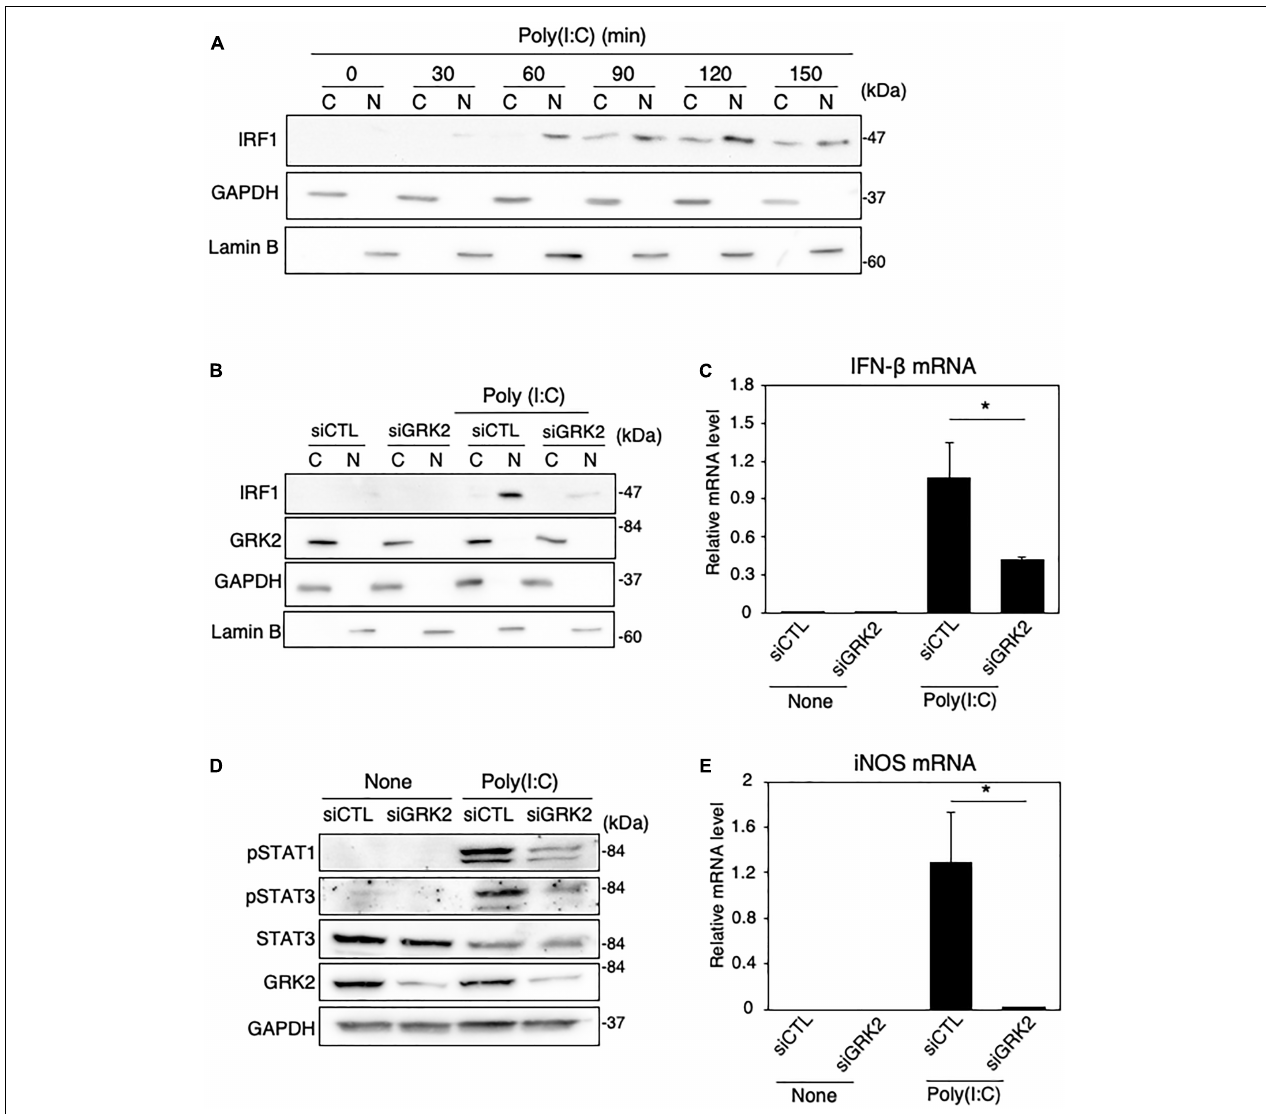
FIGURE 8 | Effect of GRK2 siRNA transfection on TLR3-mediated signaling for iNOS expression in MG6 cells. (A) Cytoplasmic (C) and nuclear (N) fractions were isolated, and then the time course of changes in IRF1 levels in each fraction after 50 µ g/ml poly(I:C) application was tracked by Western blot analysis. (B) Effect of transfection of GRK2 siRNAs (siGRK2) on nuclear translocation of IRF1 60 min after challenge with 50 µ g/ml poly(I:C) was compared with that when the negative control siRNAs (siCTL) was transfected. GAPDH and lamin B served as a cytoplasmic and nuclear marker, respectively. (C) Effect of siGRK2 transfection on IFN- β mRNA expression levels 3 h after 50 µ g/ml poly(I:C) application. (D) Effect of siGRK2 transfection on phospho-STAT1 at Tyr-701, phospho-STAT3 at Tyr-705, and total STAT-3 4 h after 50 µ g/ml poly(I:C) application. GAPDH served as loading control. Shown are representative Western blots from three independent experiments in which the same results were obtained. (E) Effect of siGRK2 transfection on expression of iNOS mRNA 12 h after 50 µ g/ml poly(I:C) application. The mRNA levels were expressed as a fold increase above control normalized GAPDH. The results represent the mean ± SEM for three independent experiments. ∗ P < 0.05 by t -test.